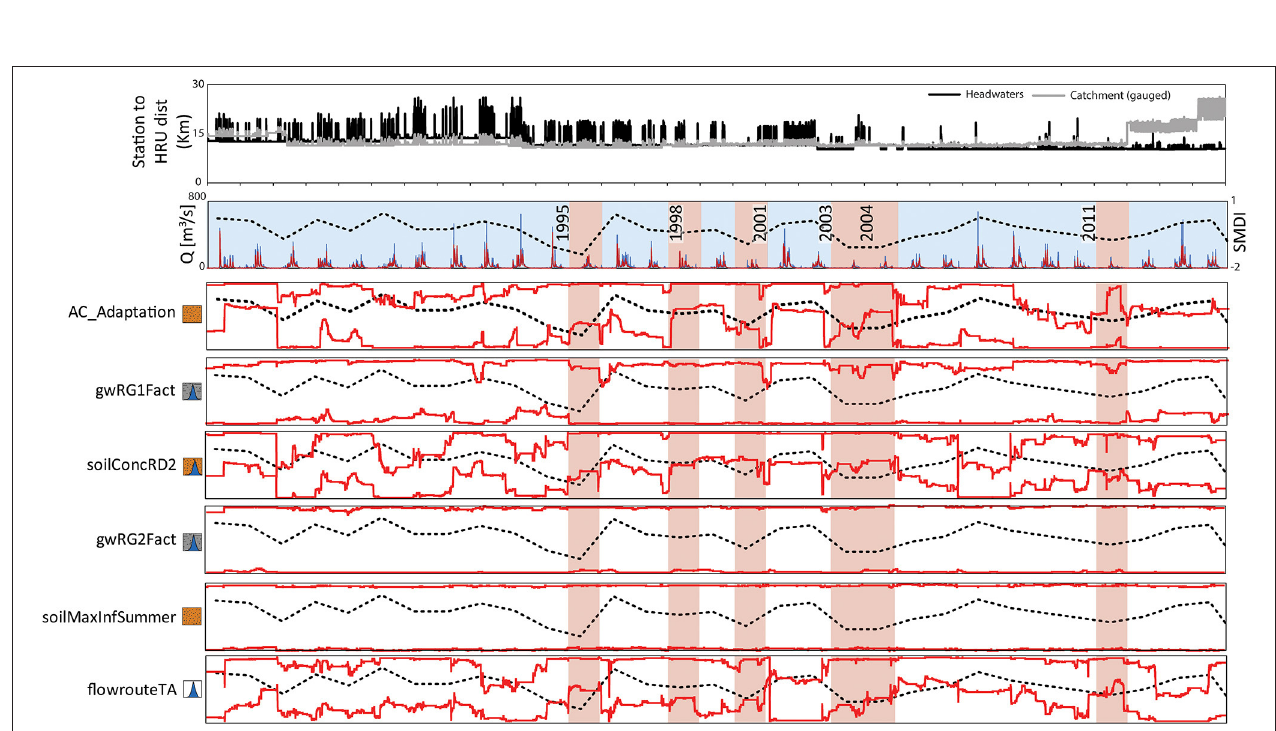
FIGURE 10 | The precipitation to HRU distance in the catchment headwater (black line) and for the gauged portion (gray line), simulated (red line) and observed streamflow (blue line), the simulated Soil Moisture Deficit Index (black dashed line) (after Watson et al., 2022). The upper and lower bounds of the Dynamic Identifiability Analysis (DYNIA) using the Nash–Sutcliffe (NSE; Nash, 1970) efficiency in standard form (E2) for the selected parameters showing temporal parameter uncertainty, considering the station to HRU distance, simulated SMDI and the streamflow for different “dry” and “wet” periods. The alignment of these three datasets show three periods of similar model uncertainty from 1984–1994, 1995–2005, and 2006–2014.